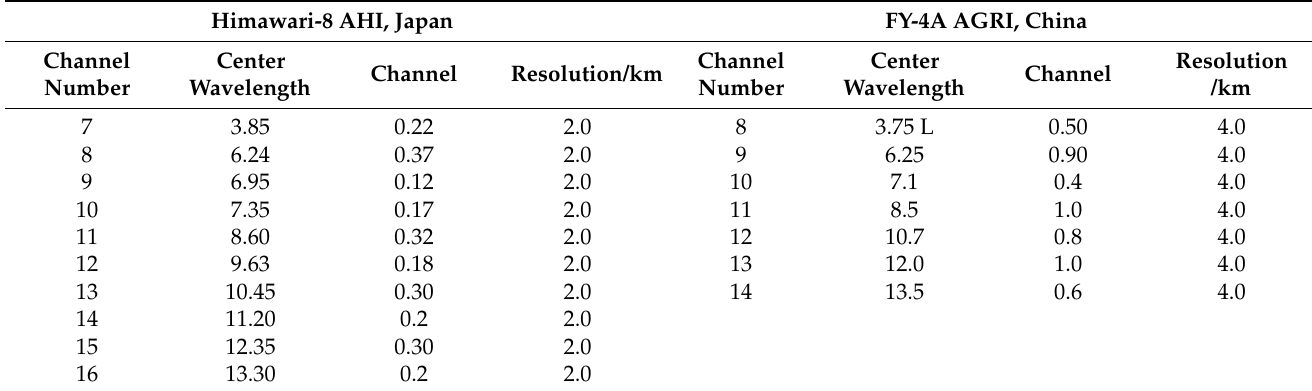
Table 1. Characteristics of each channel parameter of the AHI and AGRI.